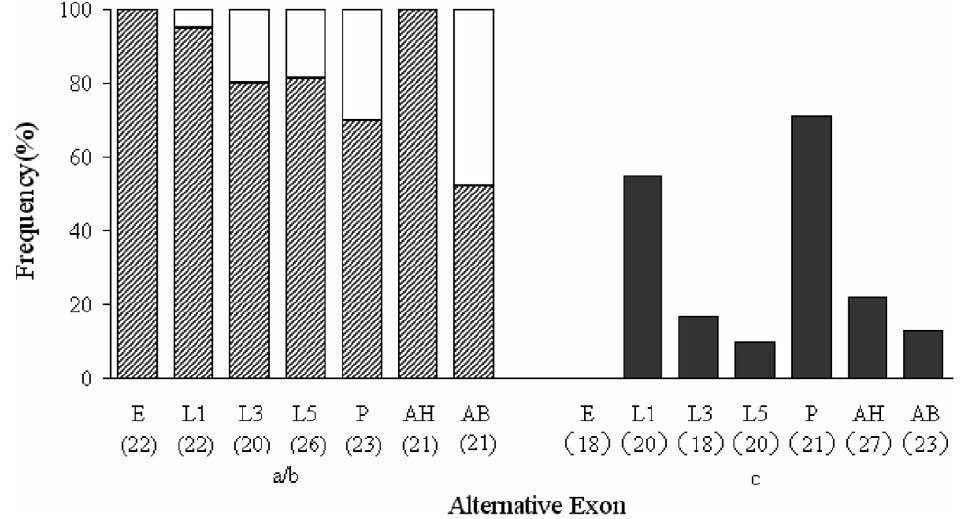
Figure 6. Relative frequencies of individual CmRyR alternative exon usage in eggs (E), first instar larvae (L1), third instar larvae (L3), fifth instar larvae (L5), pupae (P), adult heads (AH), and adult bodies (AB). Mutually exclusive exons are represented by hatched bars (exon a) and open bars (exon b). Optional exon c is indicated by black bars. Numbers in parentheses represent the total numbers of clones investigated.